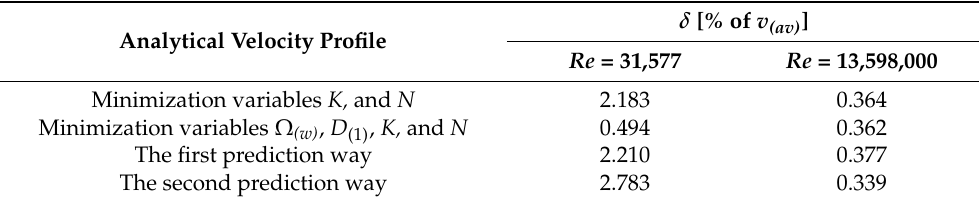
Figure 23. The experimental data (PSP) for Re = 13,598,000 comparison with predicted mean velocity profile. The average velocity and Re are known in this case. All other parameters are evaluated from the empirical expressions. Dashed line with circles represents the experimental data, the solid line is the analytical profile. ( a ) Normalized mean velocity profile, ( b ) Normalized vorticity distribution. Table 3. The mean velocity profile precession comparison for different ways of prediction. The comparison is done through the value δ .